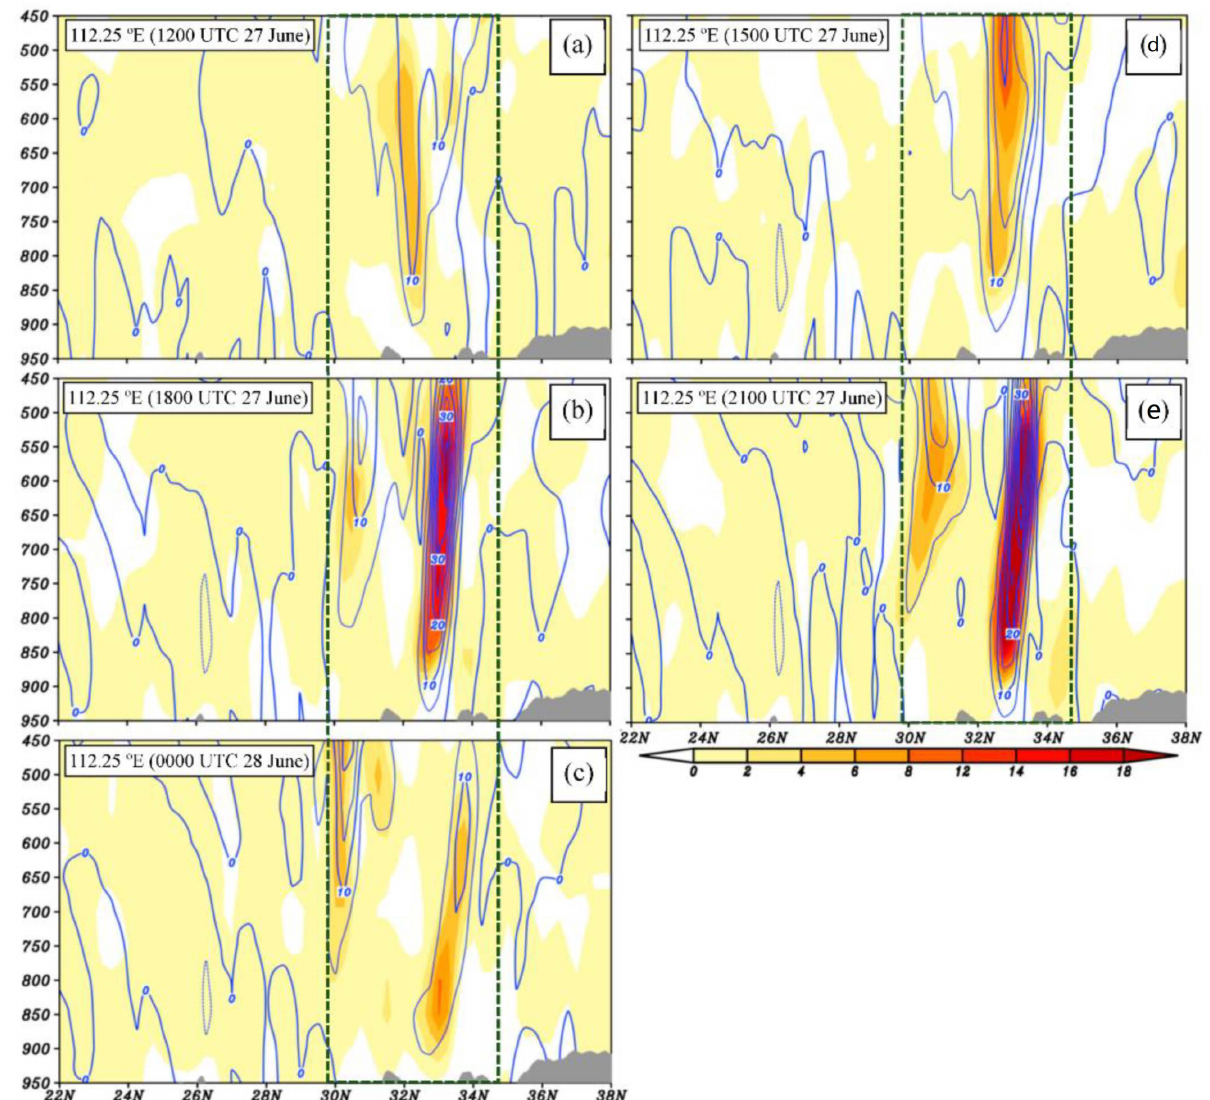
Figure 8. Panels ( a – e ) show the zonally (from 109.25 ◦ E to 115.25 ◦ E) averaged term VAV (shading, units: 10 − 9 s − 2 ), and vertical velocity (blue lines, units: cm s − 1 ). Grey shading shows the terrain, and the green dashed lines mark the central location of the mesoscale vortex. Y labels in all figures are pressure (units: